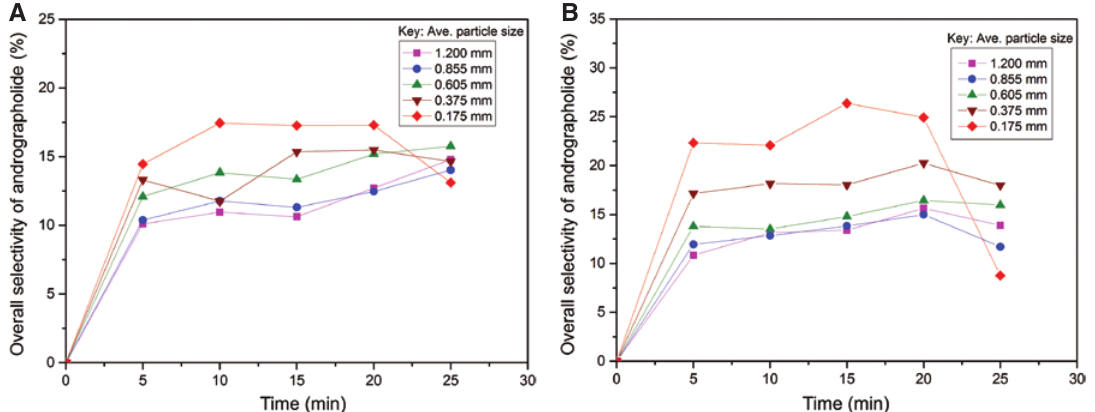
Figure 7: Effect of particle size on the overall selectivity of andrographolide from Andrographis paniculata (AP) in the green solid-liquid extraction at 80 ° C for solid-liquid ratio of (A) 1:10 (g ml -1 ) and (B) 1:50 (g ml -1